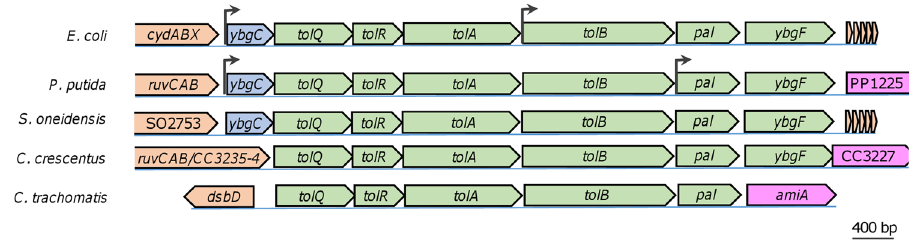
Figure 1. Organization of the tol-pal cluster in representative bacteria. Genes flanking the tol - pal cluster vary. Operon structures for the tol-pal cluster have been determined only in E. coli and P. putida , with promoters shown by arrows. In some bacteria, ybgC is missing in the tol - pal cluster and in extremely rare cases, both ybgC and ybgF are missing. Genes are drawn to scale. BLASTp E-values of S. oneidensis counterparts to E. coli YbgC, TolQ, TolR, TolA, TolB, Pal, and YbgF, are 5e-40, 7e-98, 8e-16, 2e-10, 9e-133, 8e-56, and 1e-22,